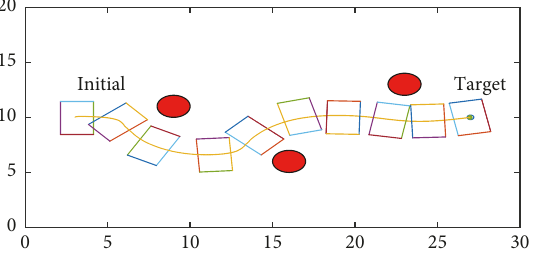
Figure 8: Evolution of trajectories for a lead-carrier team consisting of one leader and three carriers. The corners of the boxes represent the position of the end-effectors of the leader and the three followers. Here we have a rectangular formation.